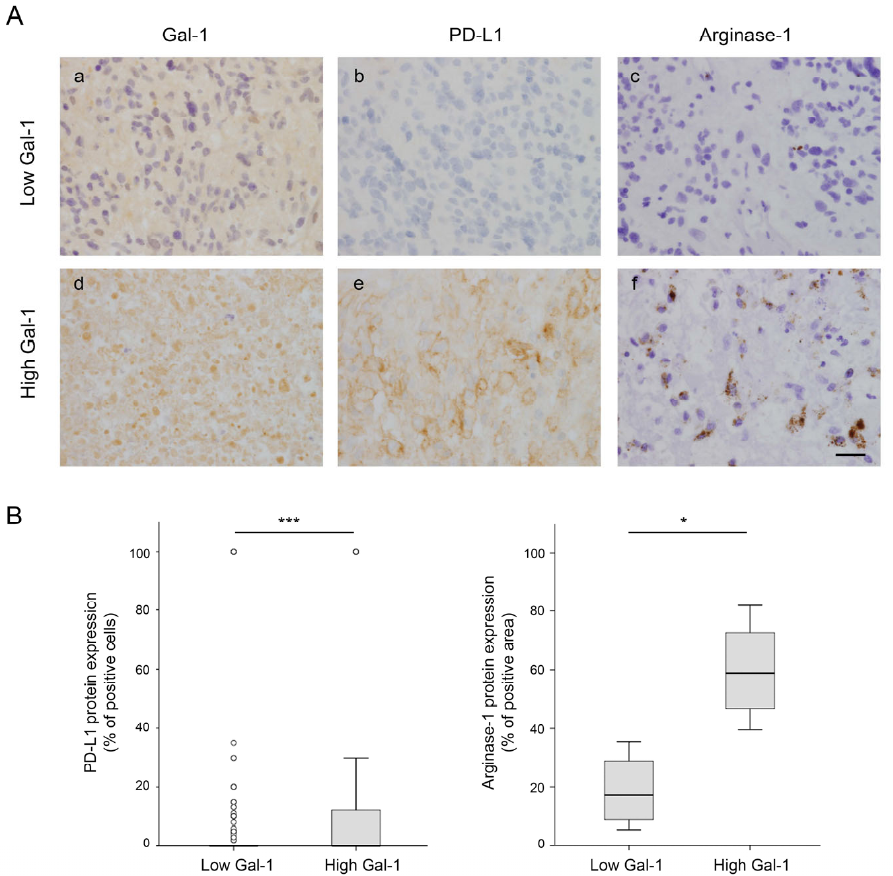
Figure 5. Gal-1 expression and correlation with PD-L1 or Arginase-1 expression in GBM. ( A ) Representative images of Gal-1 ( a , d ), PD-L1 ( b , e ), and Arginase-1 (labeling M2 macrophages) ( c , f ) immunostaining in two representative patients with low (upper lane) or high (lower lane) Gal-1 H-scores. Scale bars, 25 µ m. ( B ) Immunohistochemistry quantification of PD-L1 (left panel) in GBM patients included in the TMA ( n = 263) and Arginase-1 (right panel) in low or high Gal-1 representative patients ( n = 8). * p < 0.05; *** p < 0.001 (Mann ‐ Whitney U test).